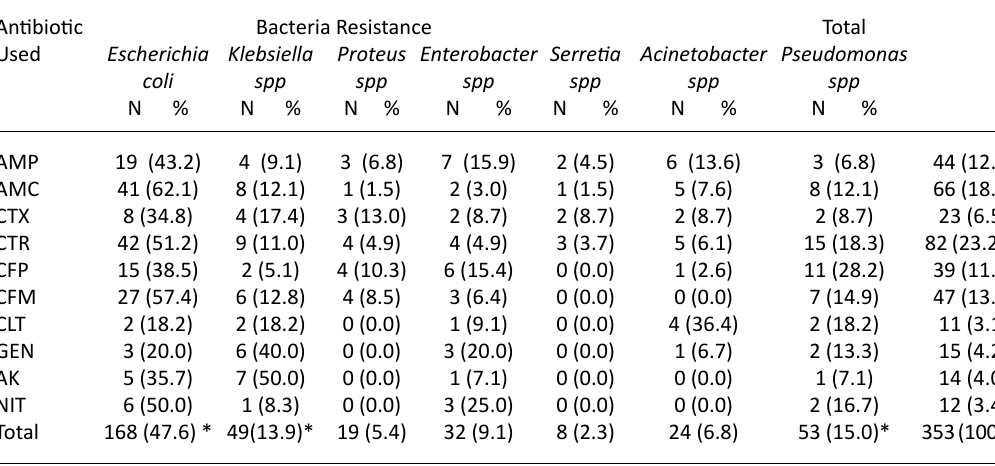
Table 3. Antibiotic Resistance in Gram Negative Bacilli Antibiotic Bacteria Resistance Total